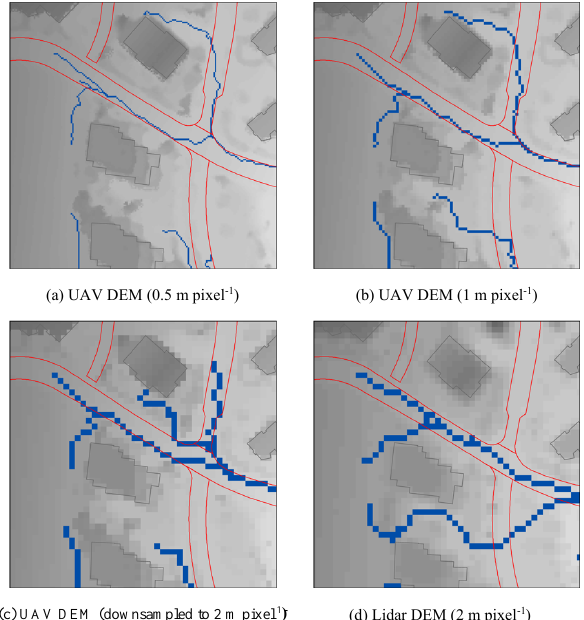
Figure 11. DEM-based flow path